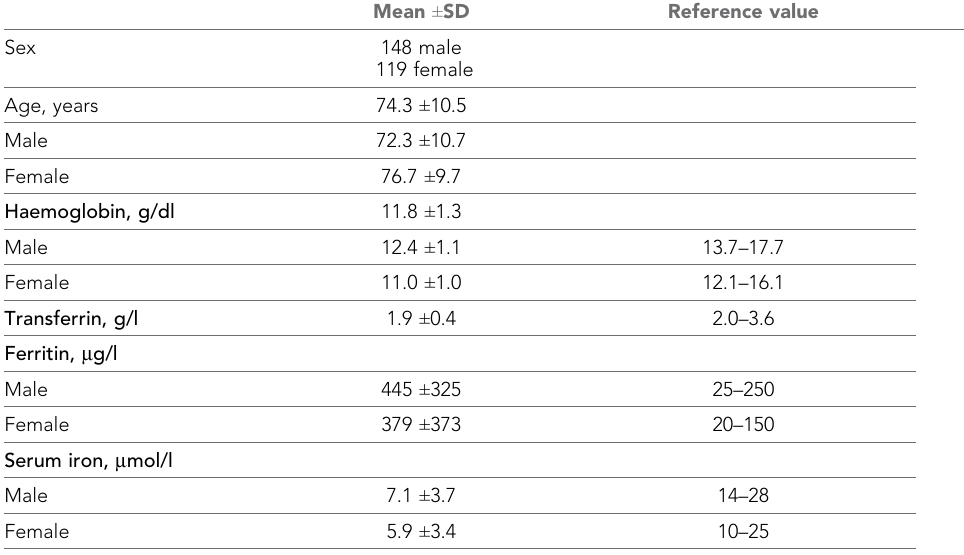
Table 1. Characteristics of the study population ( n =